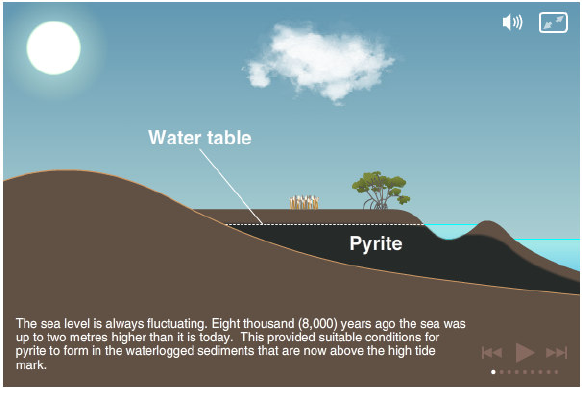
Figure 4. Coastal Acid Sulfate Soil animation.